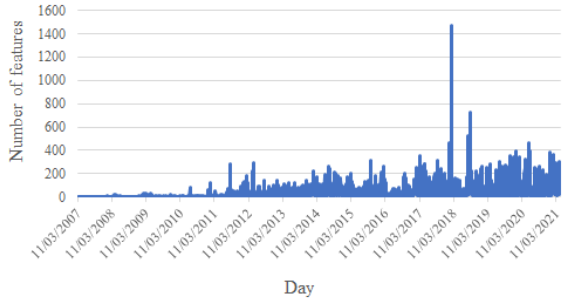
Figure 3. Repartition of the dates of creation of features with no source in our ”roads” dataset.